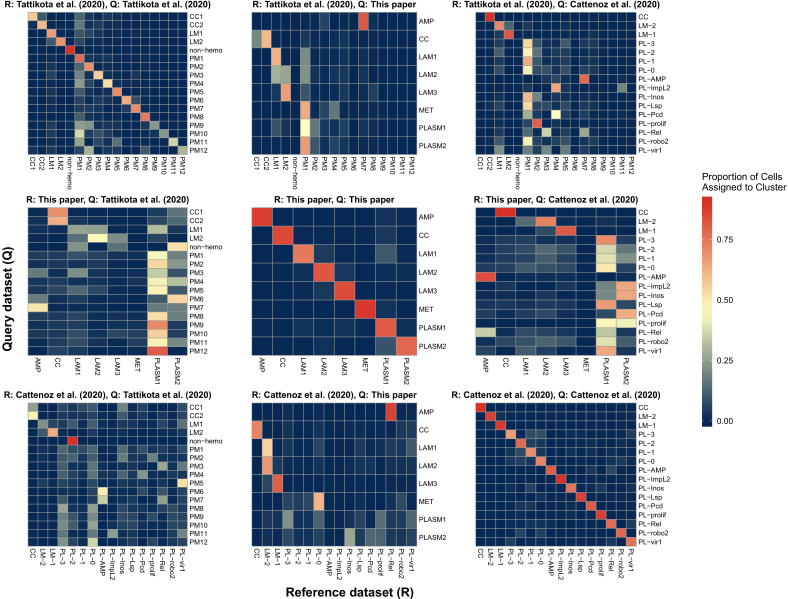
Comparison of scRNA-seq data sets from this paper to those from two previously published studies (Cattenoz et al., 2020; Tattikota et al., 2020).A reference-based label transfer was used to predict cell cluster identity in the query data set. The scale bar indicates the proportion of cells in query clusters (y axis) that are predicted to belong to a given reference cluster (x axis).